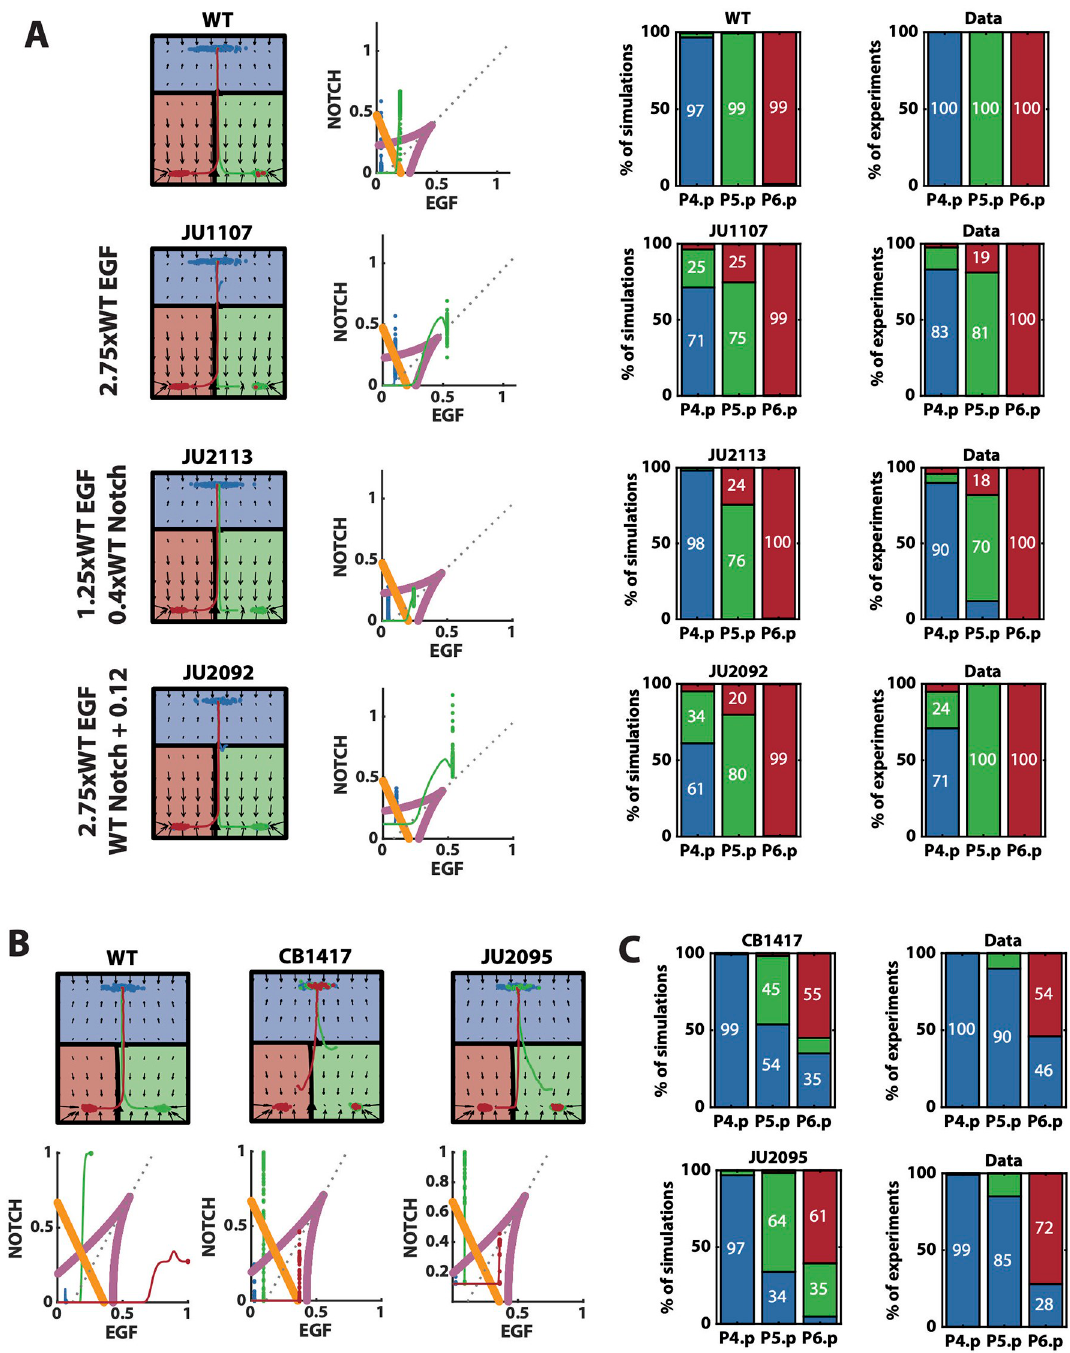
Fig 6. Model’s further validations. (A) Left: Representative mean trajectories on the landscape and signal space for simulated WT vulva and different signal perturbations included in the validation data set. Blue, green and red trajectories represent the evolution of the state of P4.p, P5.p and P6.p, respectively. Right: Mean simulated and experimental patterns for the different perturbations shown on the left. Blue, green and red represent tertiary, secondary and primary fates, respectively. (B) Representative mean trajectories on the landscape and signal space for simulated WT vulva and EGF hypomorph perturbations. Blue, green and red trajectories represent the evolution of the state of P4.p, P5.p and P6.p, respectively. (C) Mean simulated and experimental patterns for the EGF hypomorph perturbations. Blue, green and red represent tertiary, secondary and primary fates, respectively.